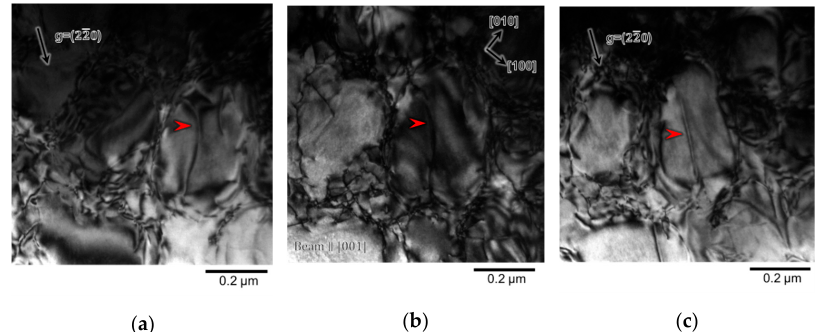
Figure 15. Bright-field image in the root of the ruptured specimen using TEM in the various tilting conditions within the gauge of the ruptured specimen. The red arrow indicates bowed out paired dislocation, which is focused on: ( a ) 20.3° from [001] along Kikuchi band with (cid:4666)22(cid:3364)0(cid:4667) on the side of (cid:4670)1(cid:3364)1(cid:3364)1(cid:4671) with g= (cid:4666)22(cid:3364)0(cid:4667) , ( b ) from the view of (cid:4670)001(cid:4671) , ( c ) 32.4° from [001] along Kikuchi band with (cid:4666)22(cid:3364)0(cid:4667) on the side of (cid:4670)111(cid:4671) with g= (cid:4666)22(cid:3364)0(cid:4667).